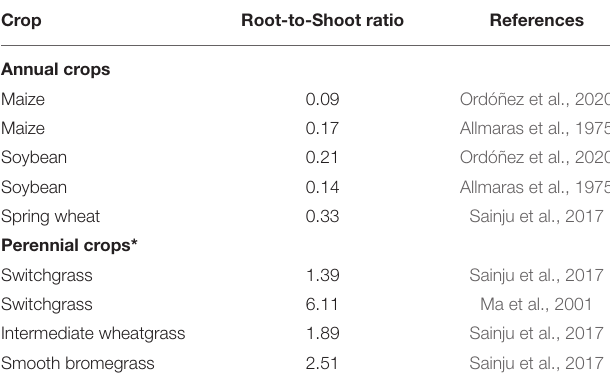
TABLE 1 | Root-to-shoot ratios of annual and perennial crops measured at the end of the growing season. Crop Root-to-Shoot